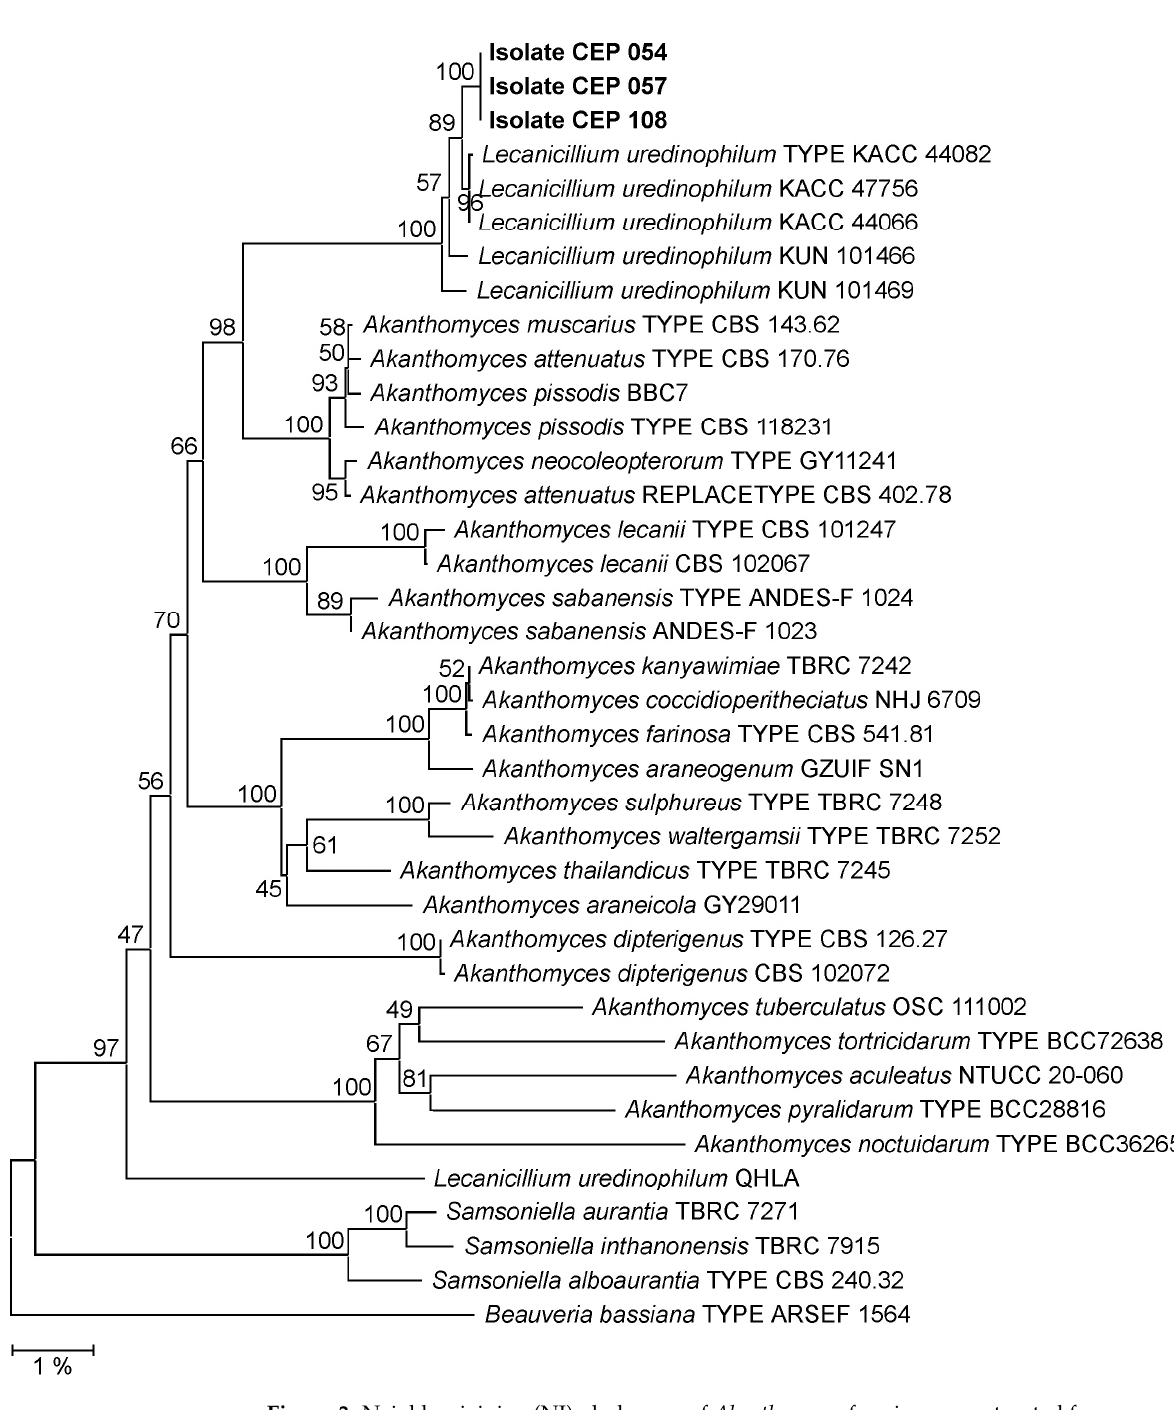
Figure 3. Neighbor joining (NJ) phylogeny of Akanthomyces fungi as reconstructed from concatenated EF1A, RPB1 and RPB2 nucleotide sequences. Terminal branches are labeled by genus, species and strain designations; “TYPE” indicates specific type strains. Designations of fungal isolates from Argentina are shown in bold face. Numbers on internal branches indicate bootstrap support percentages. The size bar corresponds to 1% sequence divergence with respect to phylogram branch lengths. A concatenation of orthologous sequences from the fungal entomopathogen Beauveria bassiana (Hypocreales; Cordycipitaceae) has been used as the outgroup.